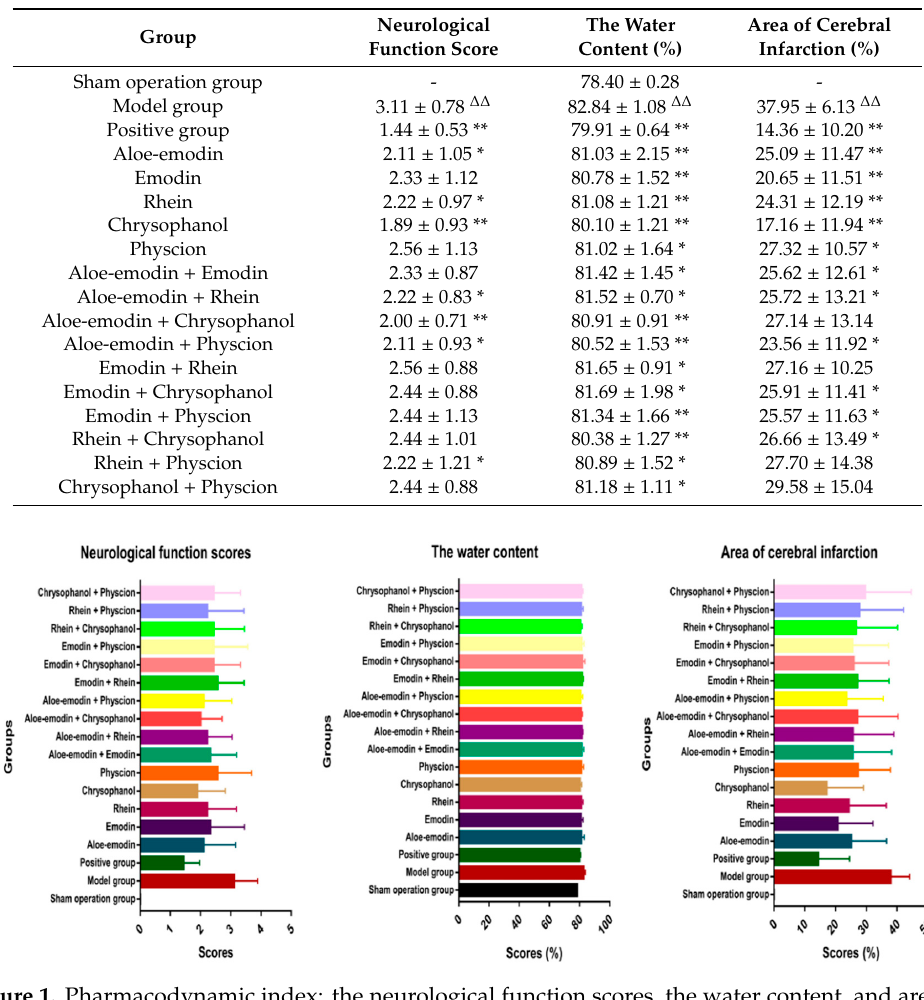
Figure 1. Pharmacodynamic index: the neurological function scores, the water content, and area of cerebral infarction. The results are expressed in terms of means ± standard deviation (n = 10).